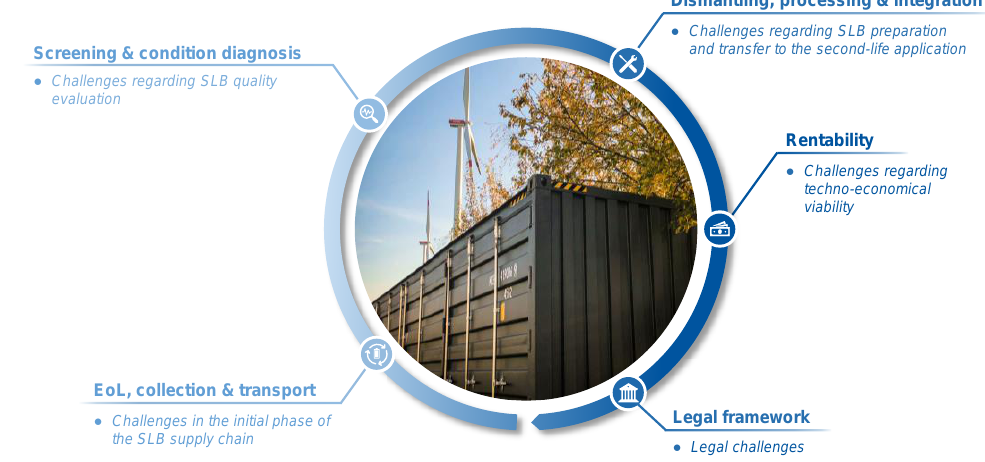
Figure 1. Thematic overview of challenges for second life batteries.